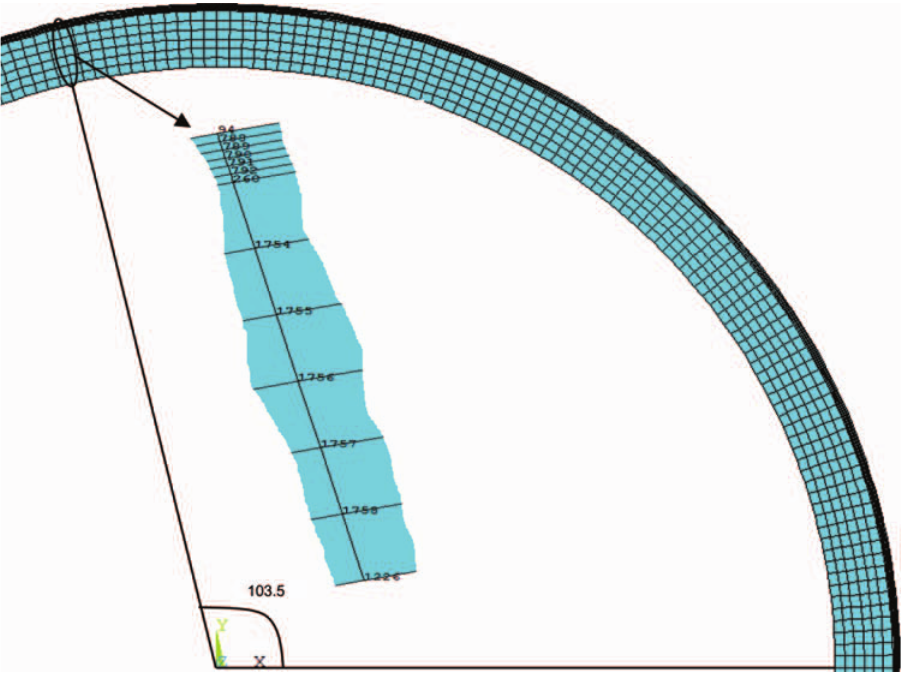
Figure 7 FE mesh and locations of nodes 94, 788 – 792, 260, 1754 – 1758 and 1226 along radial direction at angle 103.5 ° . Nodes 1226 to 260 are in the mandrel. Nodes 792 to 94 are in the composites.